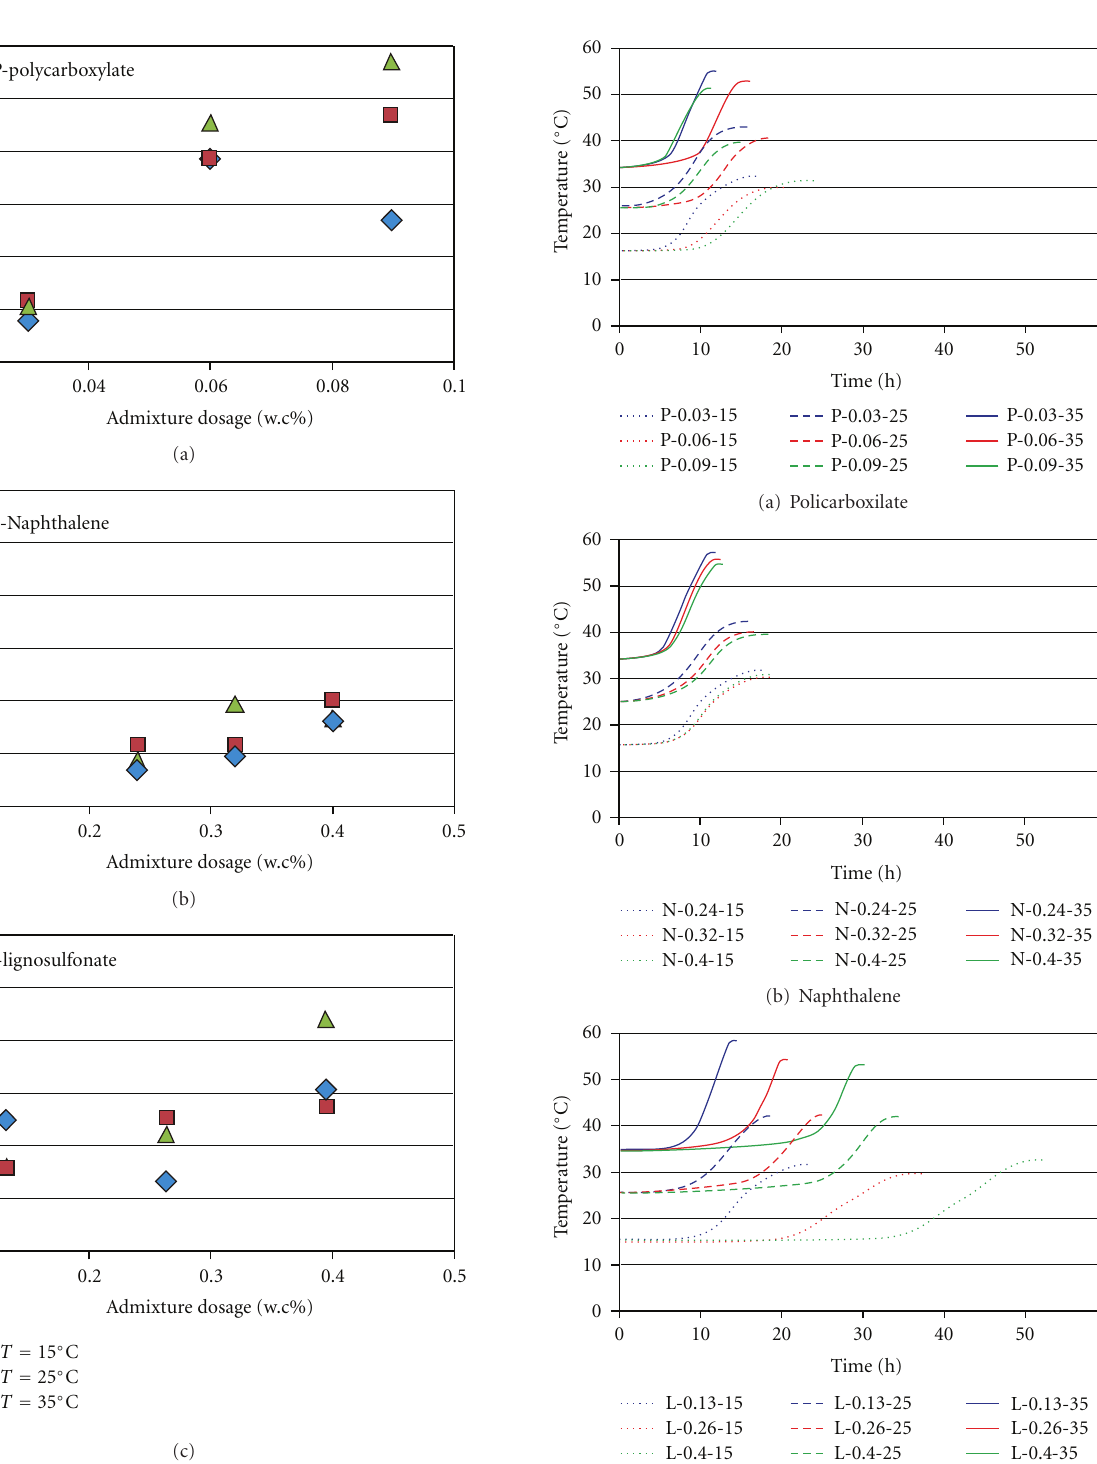
Figure 9: E ff ect of temperature variation and admixture dosage on air content.